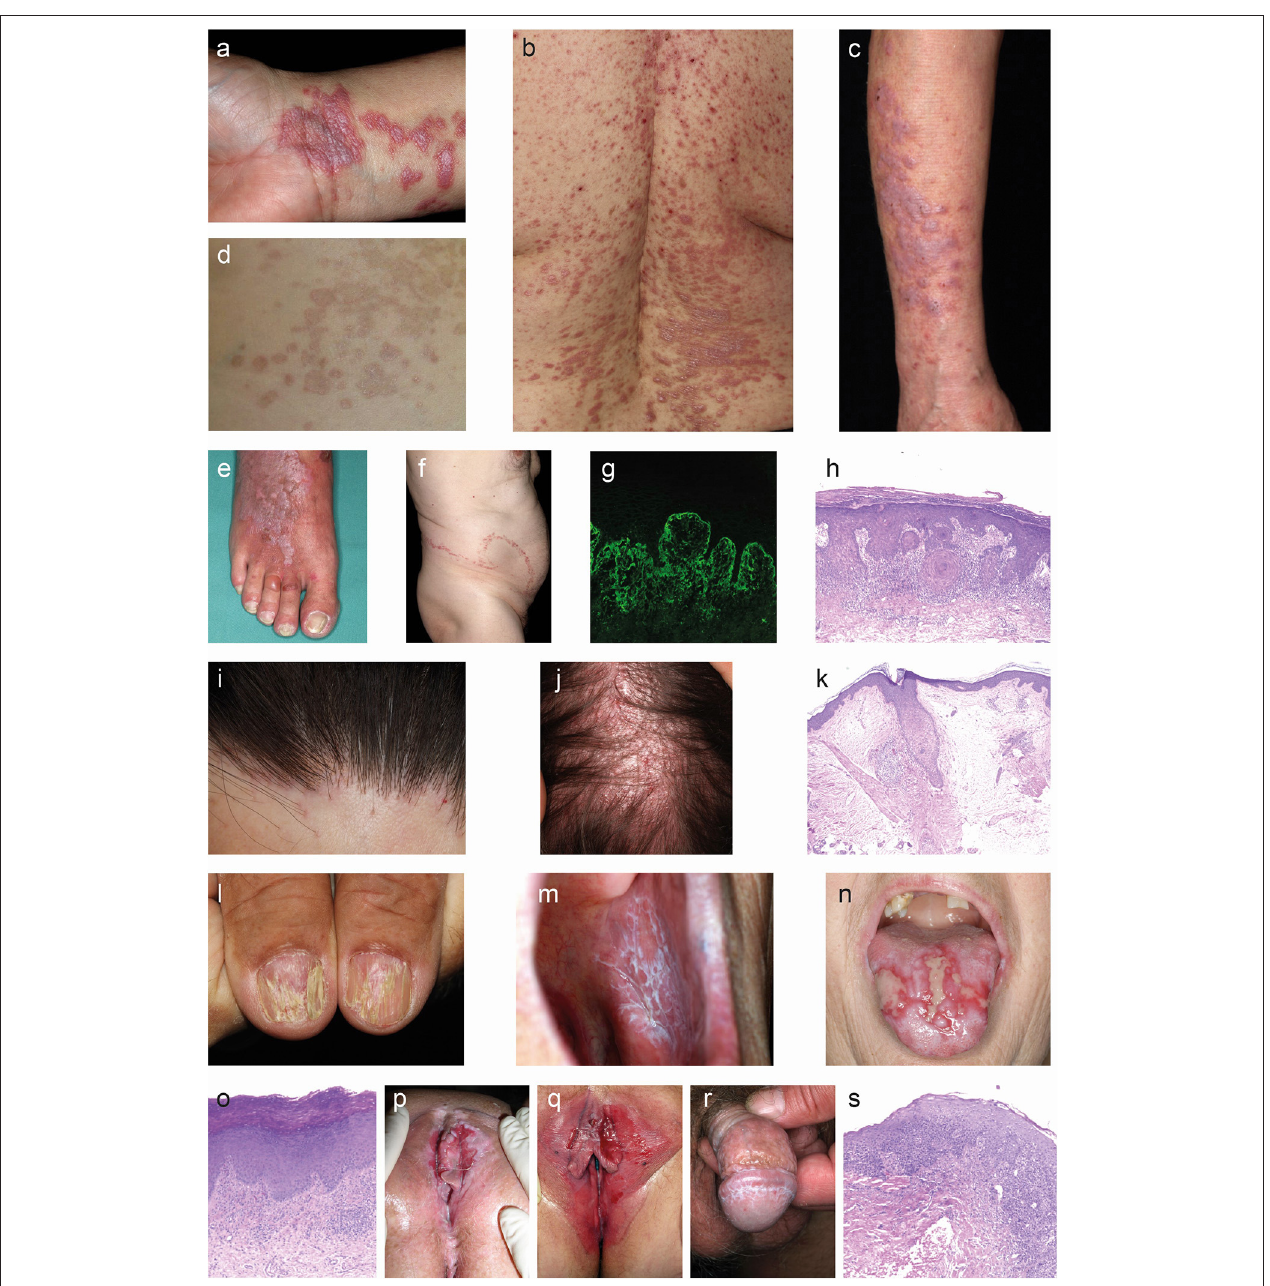
FIGURE 1 | Clinical and histological hallmarks of lichen planus. (a–f) Cutaneous lichen planus (LP). (a) Polygonal, flat-topped, violaceous confuting plaques with fine white scales on the inner wrist in a patient with localized LP. (b) Symmetric red plaques on the back of a patient with generalized cutaneous LP. (c) Thick reddish-brown plaques on the arms of a patient with hypertrophic LP. (e) Blister on the 3rd toe along with widespread red plaques with whit streaks in a patient with lichen planus pemphigoides. (f) Linear lichen planus. (g) Direct immunofluorescence microcopy staining with fibrin deposition in the epidermis (400 × ). (h) The histology from a skin biopsy from a lichen planus lesion characteristically shows an irregularly epidermis with saw-toothed rete ridges, hypergranulosis, liquefaction degeneration of the dermal-epidermal junction and a lichenoid (band-like) lymphocytic infiltrate (H&E staining, 200 × ). (i–l) Appendageal LP. (i) Scaring alopecia and inflammation around hair follicles along the frontal scalp hair margin in a patient with frontal fibrosing alopecia. (j) Image from a patent with lichen planopilaris. (k) Lichenoid interface dermatitis of the hair infundibulum and apoptotic keratinocytes (Civatte bodies) and fibrous tracts in a biopsy from a patient with frontal fibrosing alopecia. (l) Grooved and ridged nails in a patient with nail LP. (m–s) Mucosal LP. (m) Wickham striae in the oral mucosa of a patient with oral LP. (n) Severe ulcera of the tounge in a patient with erosive oral LP. (o) Parakeratosis, acanthosis. band of inflammatory cells just beneath the epidermis, plasma cells in infiltrate in an oral biopsy from a patient with oral LP. (p) Severe vulval ulcerations in a patient with vulval LP. (q) Erythema and erosions in a patient with vulval LP. (r) Wickham striae on the glans penis in a patient with penile LP. (s) Occasional parakeratosis, irregularly thickened epidermis, apoptotic basal keratinocytes, lymphohistiocytic infiltrate in a biopsy from a patient with genital